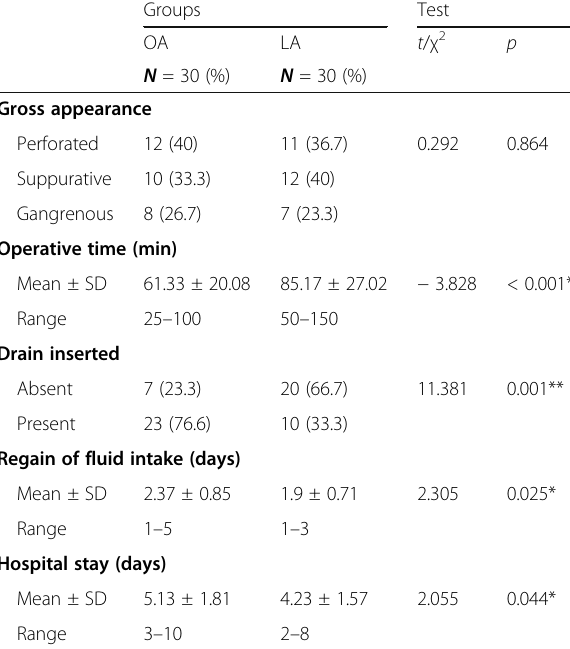
Table 1 Demographic data and preoperative TLC Groups